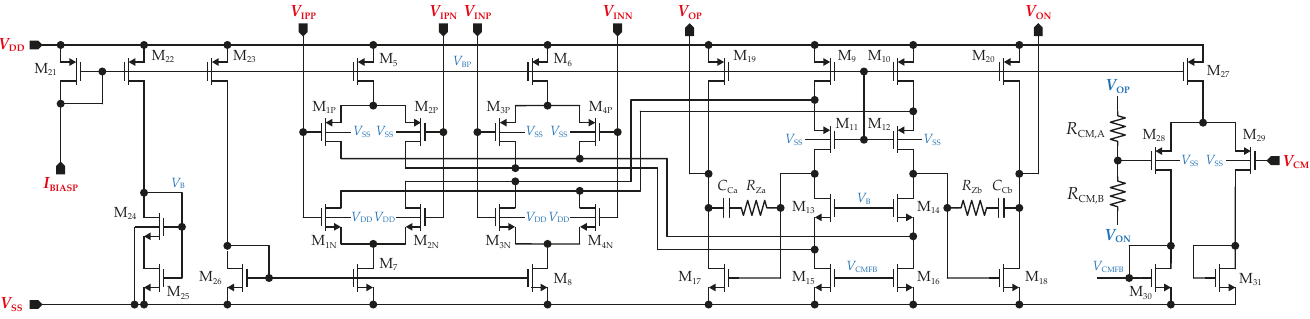
Figure 10. Topology of the proposed